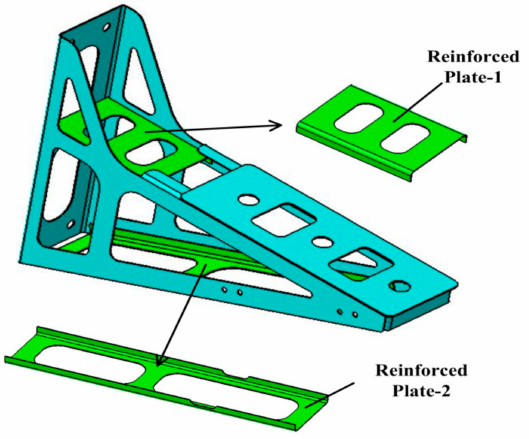
Figure 5. Structural schematic diagram of the final seat bracket.